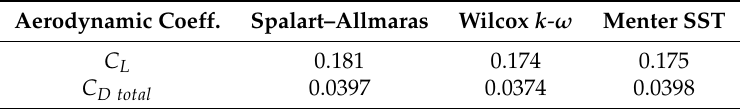
Table 4. Lift and drag coefficients in F15 aircraft at α = 5.0 ◦